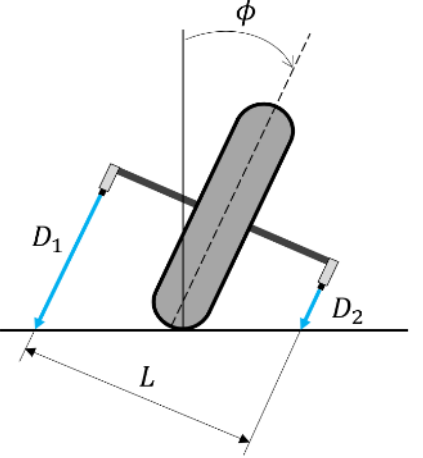
Figure 6. Range sensors on both sides of the rear wheel. D 1 — Distance signal from left laser sensor; D 2 — Distance signal from right laser sensor, L — distance between two laser sensors, φ— the true value for the roll angle.